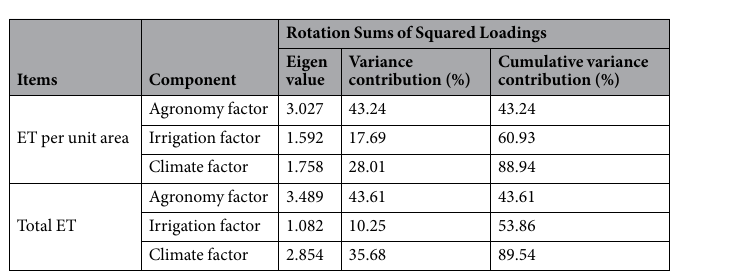
Table 5. Total variance explained in factor analysis for ET per unit area and total